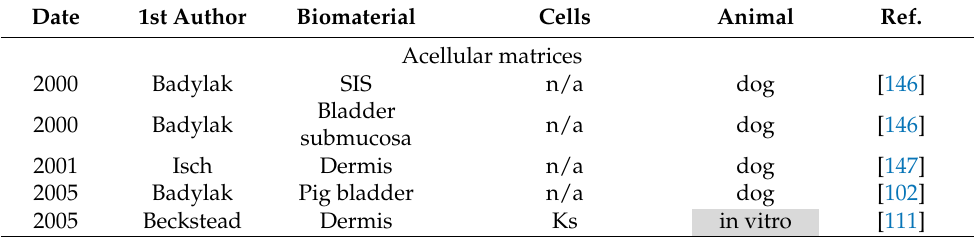
Table 3. A cellular matrix protocols for esophageal